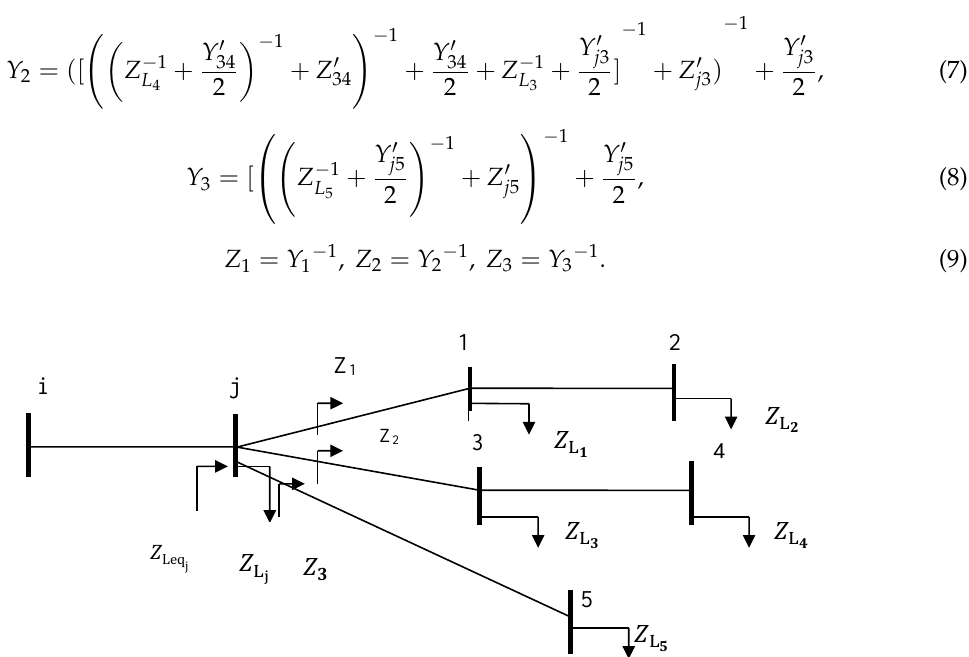
Figure 2. Single-line diagram of the sample power distribution network (PDN).